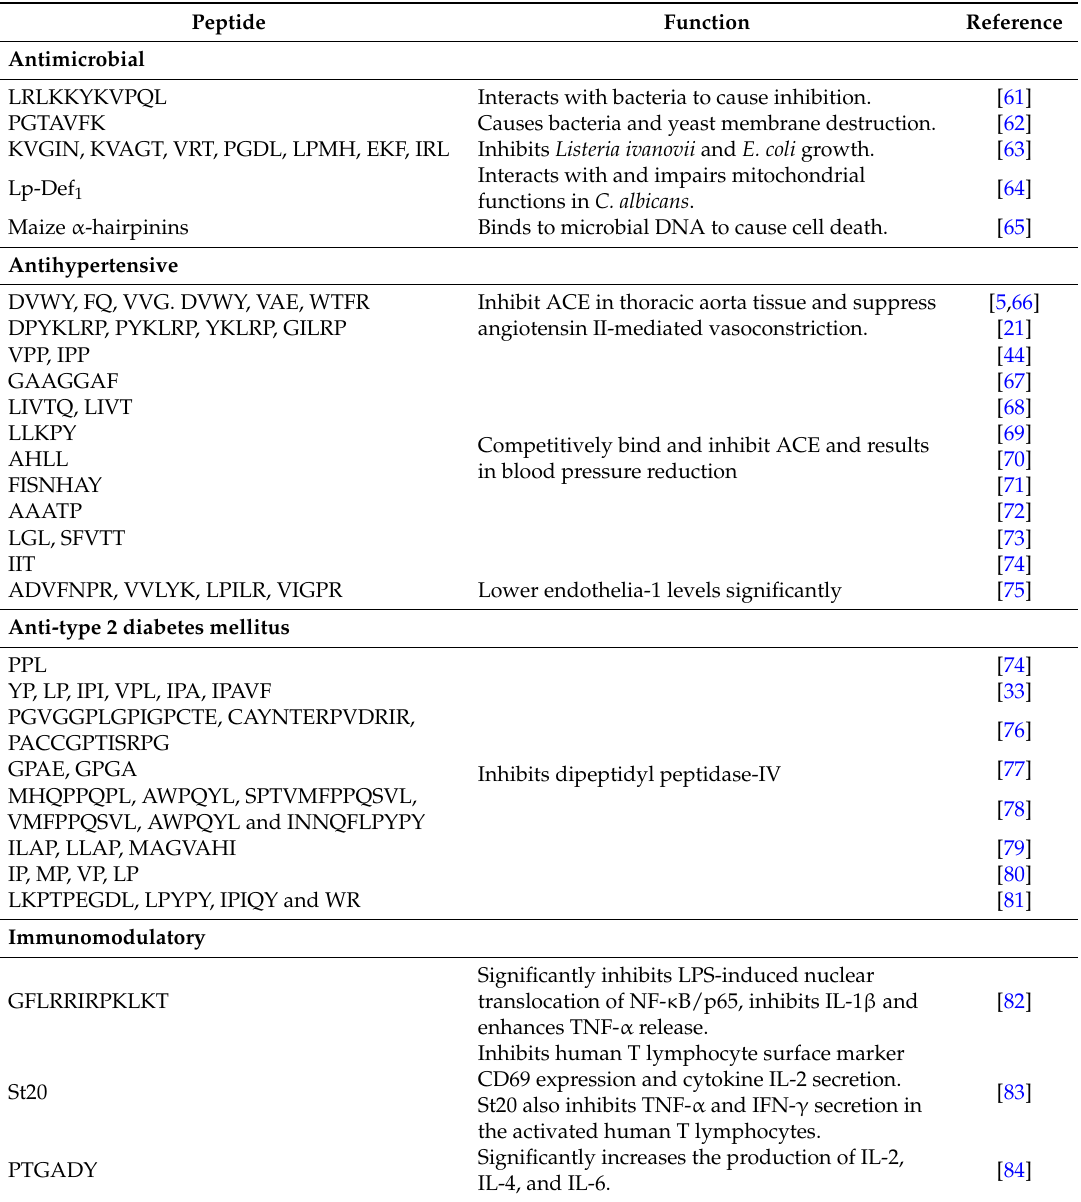
Table 1. Bioactive peptides and their